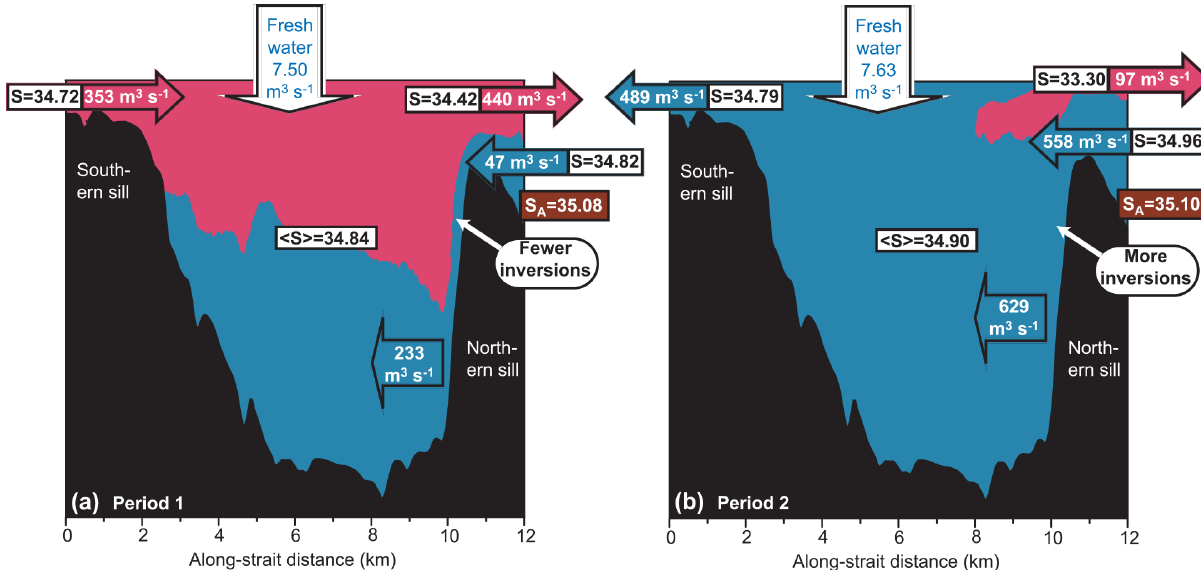
Figure 12. Schematic flow patterns and exchanges for the two periods defined in Fig. 7. Red and blue areas show northward- and southward- moving (cross-estuary averaged) flow, respectively (based on Fig. 8). Horizontal arrows over the two sills show average volume transport and (transport-averaged) salinity over the sills for each period. The wide southward-pointing arrow at depth for each period shows the total southward-moving volume transport just south of the northern sill (along-strait distance ≈ 10km). Vertical arrows show average freshwater supply to the estuary for each period, including river and hydropower supply (constant) as well as precipitation (variable). The values for <S> are the salinities averaged over the whole strait for each period. Brown boxes show the salinity, S A , for the Atlantic water at depth north of the northern sill. Differences of the frequency of density inversions over the slope south of the northern sill (white arrows) are based on Fig. 11. Note that the transport values are based on averages for each period with sea level kept constant, which explains why they do not